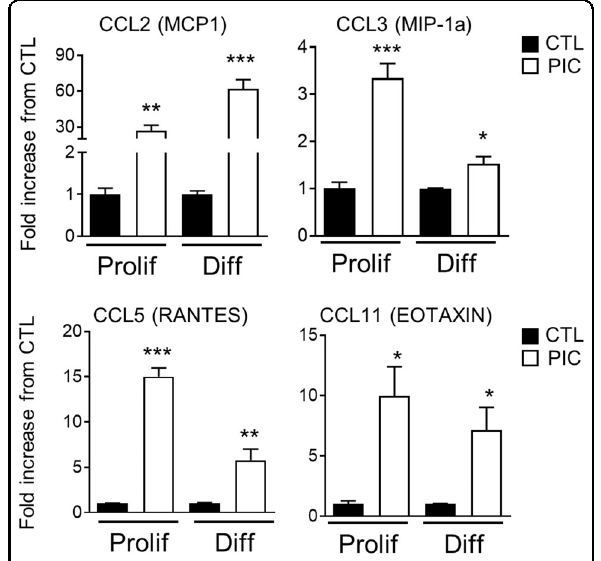
Fig. 5 CCL2, CCL3, CCL5, and CCL11 chemokines are differentially expressed at protein level in conditional medium (CM) from proliferating and differentiating OL stimulated with Poly(I:C). The expression of CCL2, CCL3, and CCL5 was measured in the culture media collected from OLs treated with Poly(I:C) (PIC) 50 ug/ml for 72 h in proliferation (Prolif) or differentiation (Diff) conditions ( n = 3, * P < 0.05, ** P < 0.01, and *** P < 0.001 Unpaired t -test).